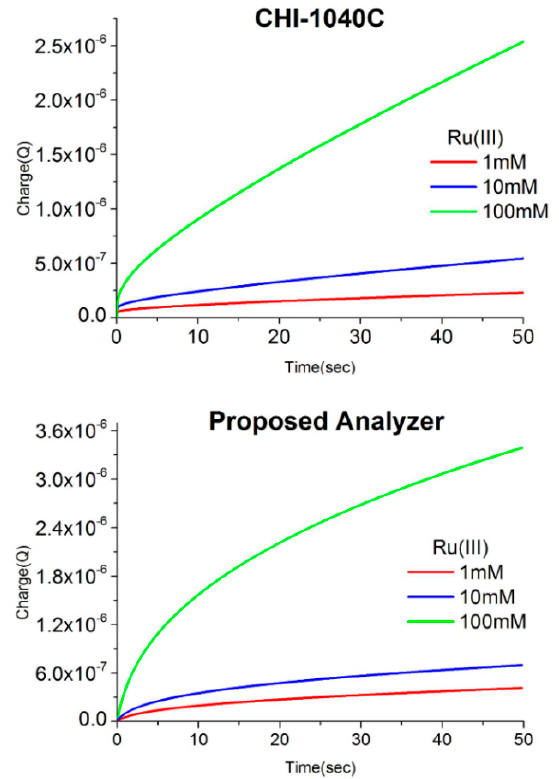
Figure 5. Charge variation with proposed analyzer and CHI-1040C.